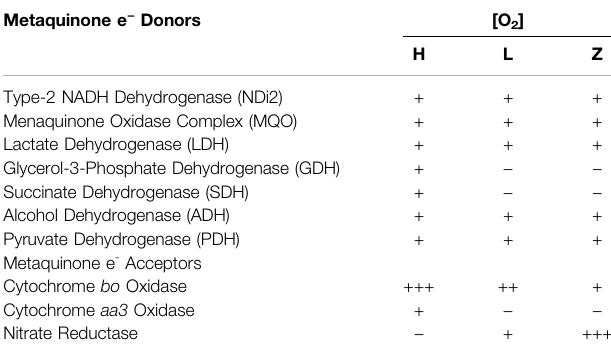
TABLE 1 | Enzyme expression at different [O 2 ] (High Low or Zero) in the S. epidermidis branched respiratory